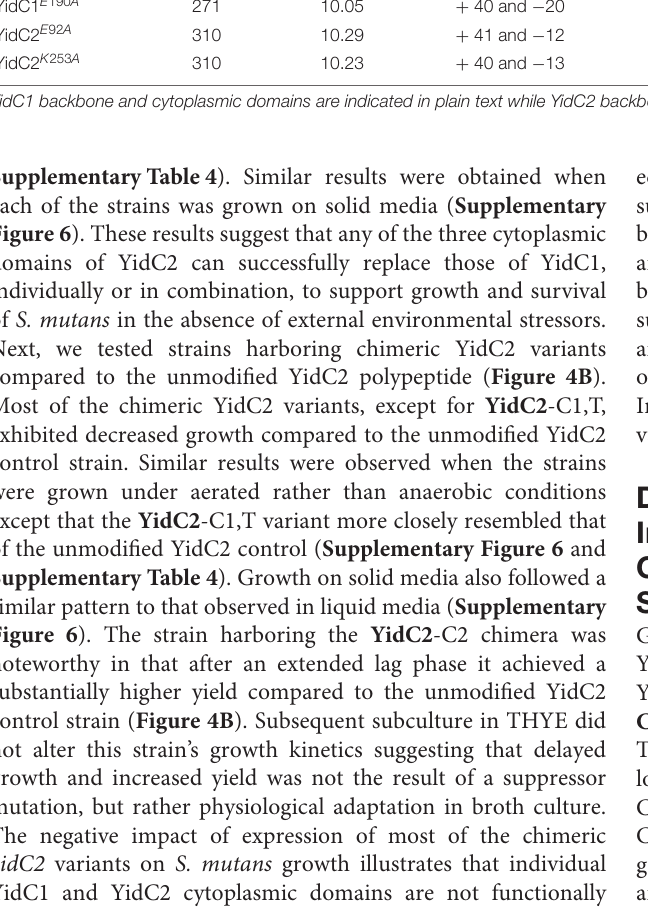
Theoretical Total no. of charged Molecular GRAVY Instability acids pI residues weight (kD)